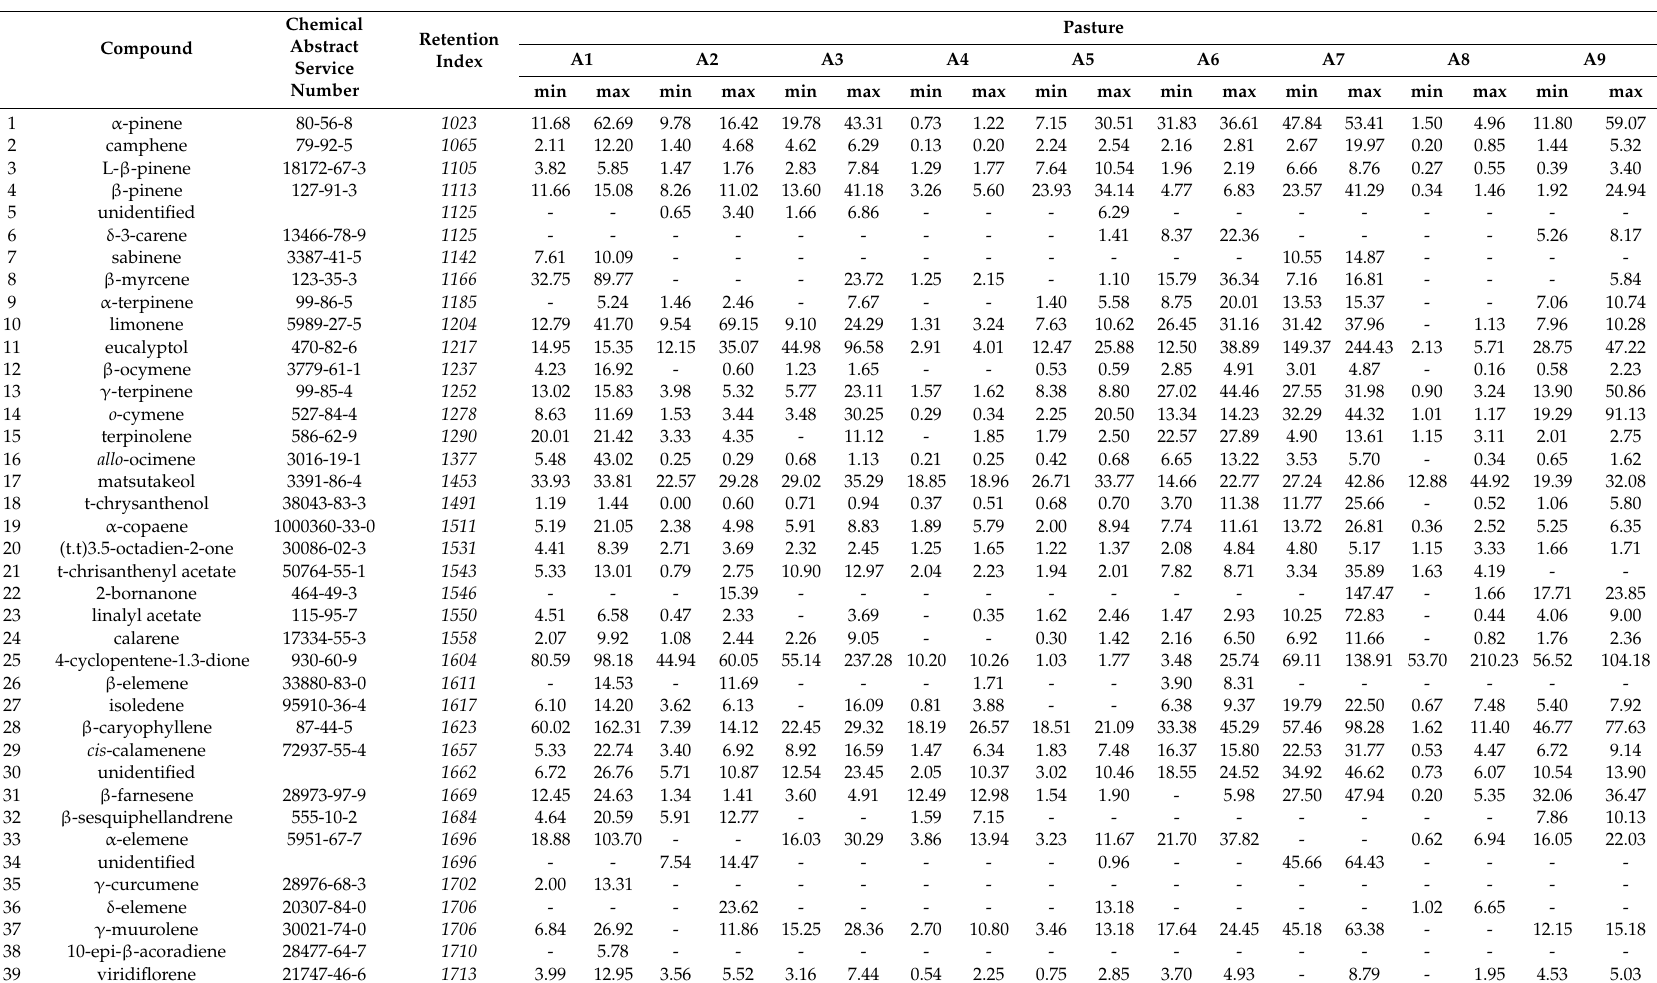
Table 4. Terpenoid content range (the min and max data are expressed as arbitrary units of the Total Ion Chromatogram peak areas × 10 -6 ) of the pastures